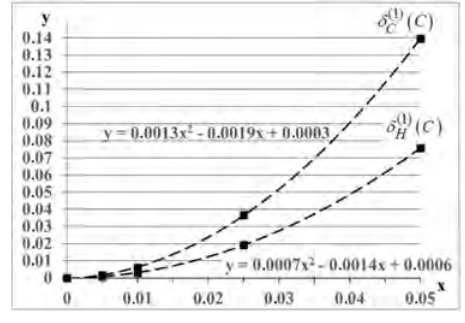
Fig. 6. (cid:4) - values of δ (1) regressions y ( x ) , x = h/a d .